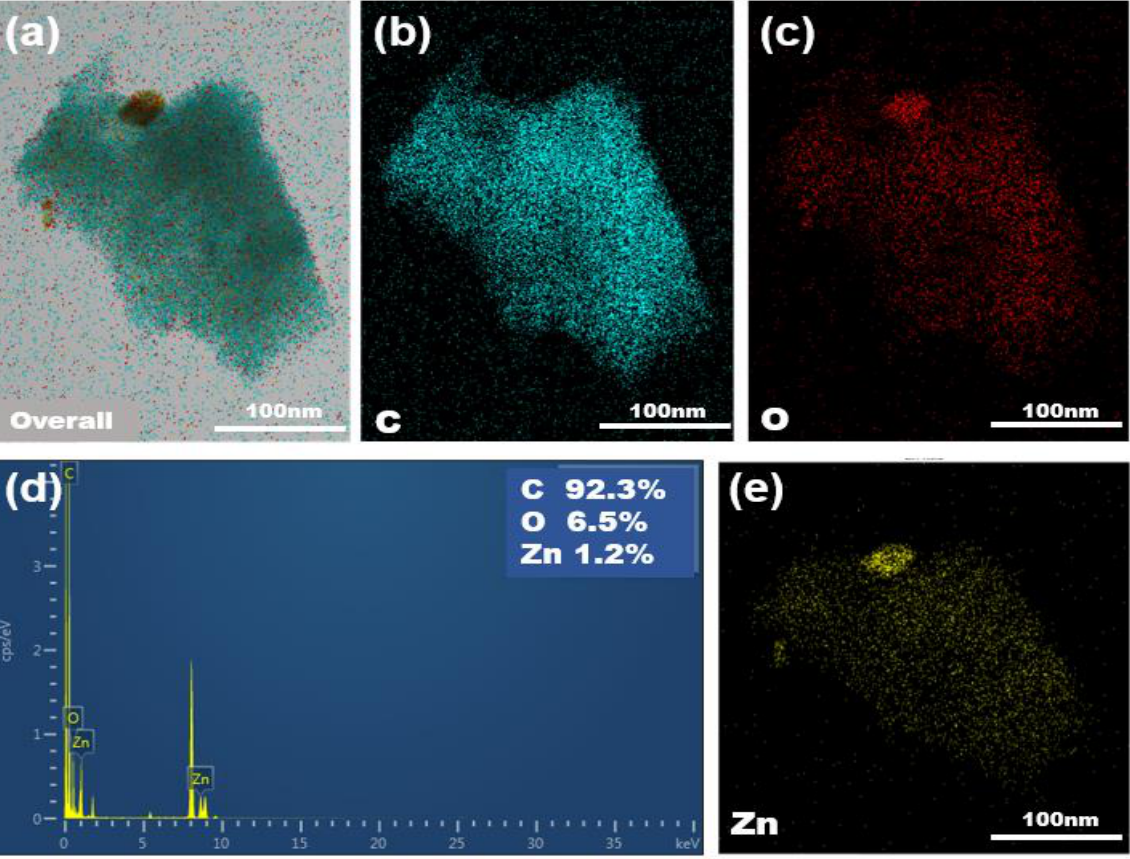
Figure 5. EDS images of Figure 3g: ( a ) Overall, ( b ) Carbon distribution, ( c ) Oxygen distribution, ( d ) EDS mapping, ( e ) Zinc distribution.